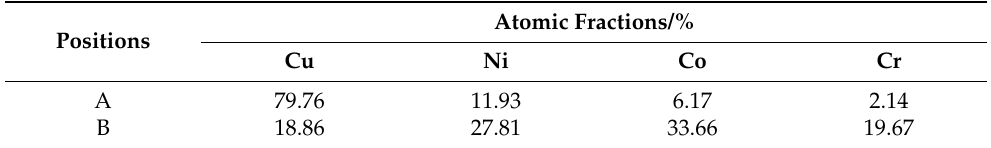
Figure 3. Microstructures and compositions of the Cu35Ni25Co25Cr15 HEA coating deposited under a welding current of 140 A: ( a ) microstructure; ( b ) distribution of all elements; ( c – f ) distribution of Cu, Ni, Co, and Cr, respectively. Table 1. Compositions of the Cu35Ni25Co25Cr15 HEA coating deposited under a welding current of 140 A.